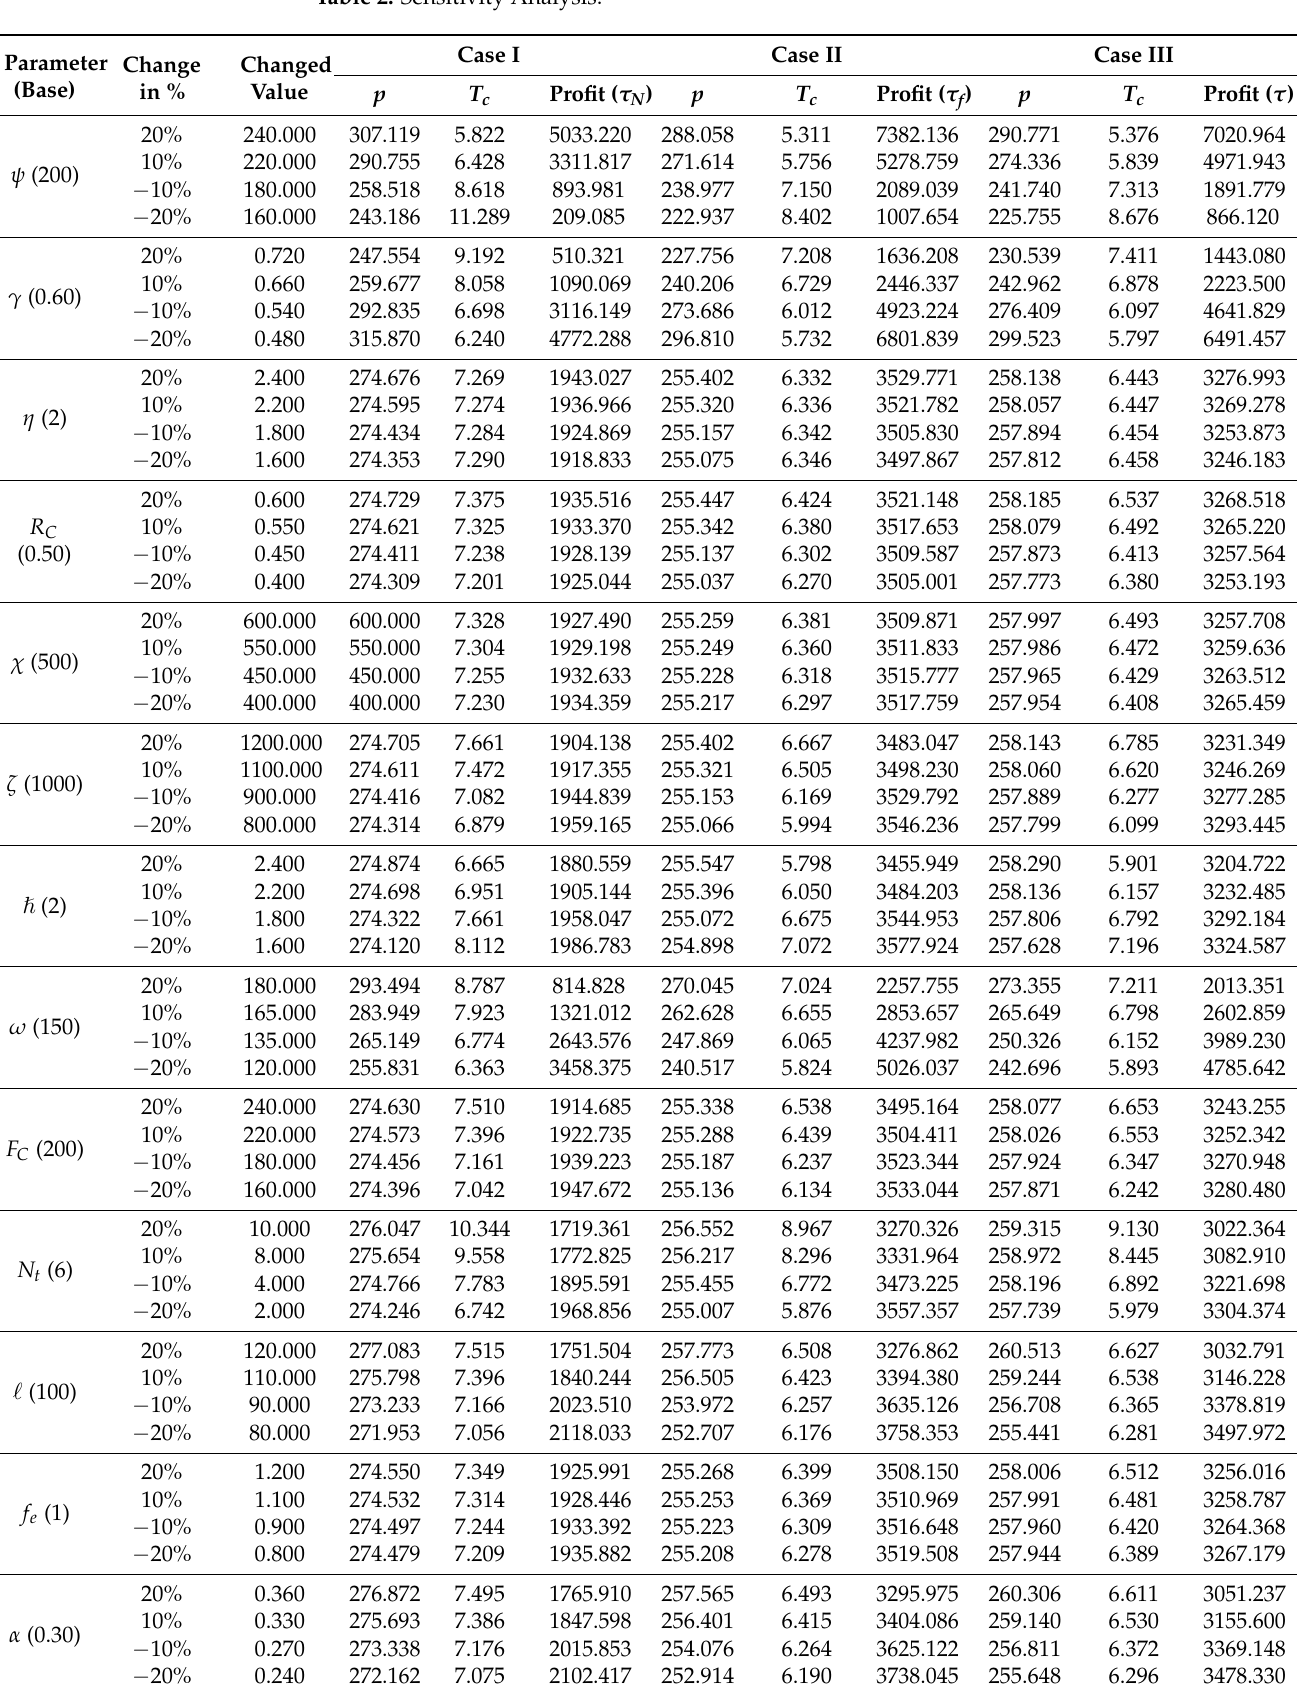
Table 2. Sensitivity